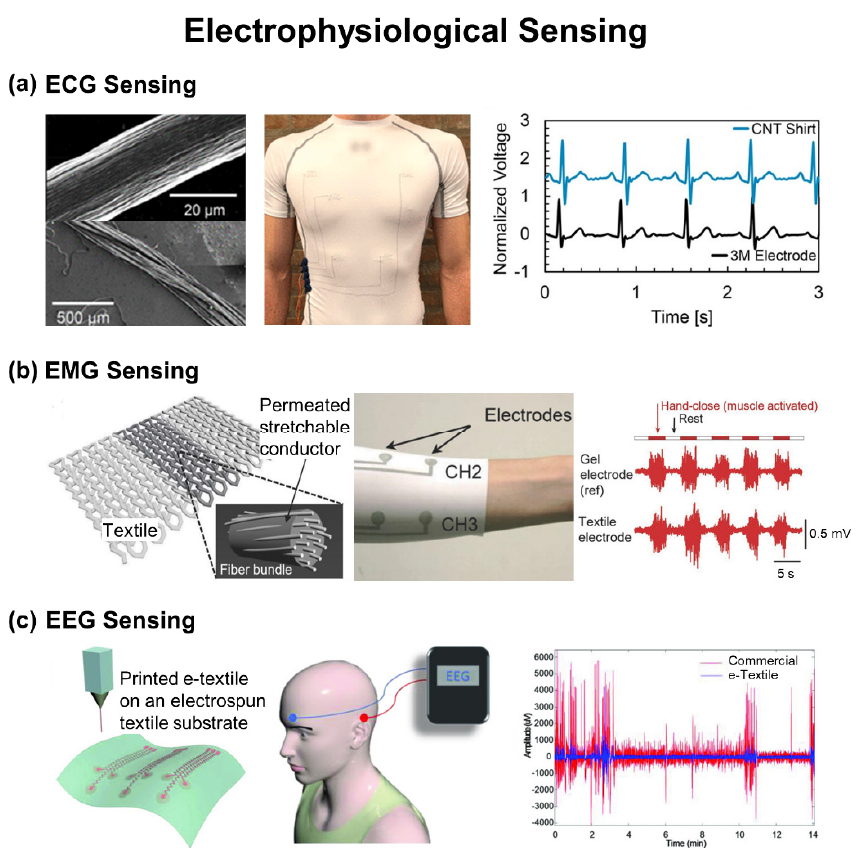
Figure 6. E-textiles for electrophysiological sensing. ( a ) ECG sensing with solution-spun CNT threads. Reprinted with permission from [127]. Copyright 2021 American Chemical Society. ( b ) EMG sensing with Ag flake-printed fabrics. Reprinted with permission from [31]. Copyright 2017 Wiley-VCH. ( c ) EEG sensing with Ag particle/fluoropolymer composite ink-printed electrospun fabrics. Reprinted with permission from [143]. Copyright 2018